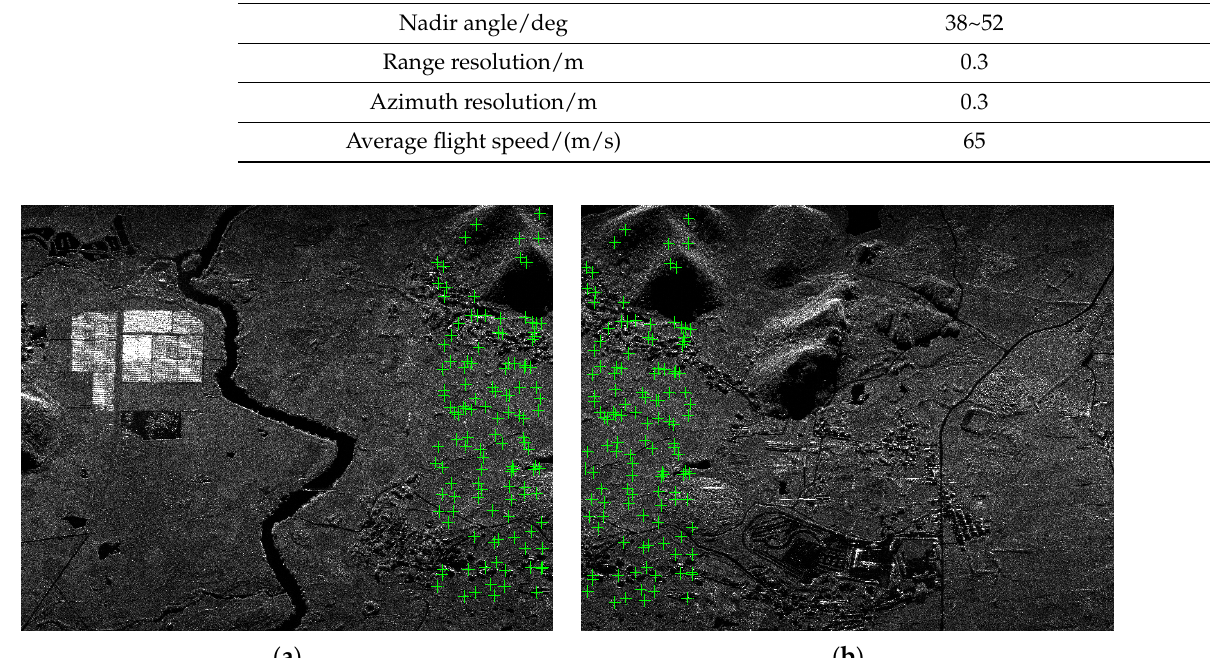
Figure 8. The position of the tie-points between the master image and the slave image within the strip, where ( a ) is the master image and ( b ) is the slave image. The horizontal axes represent azimuth direction, and vertical axes represent the slant range direction.